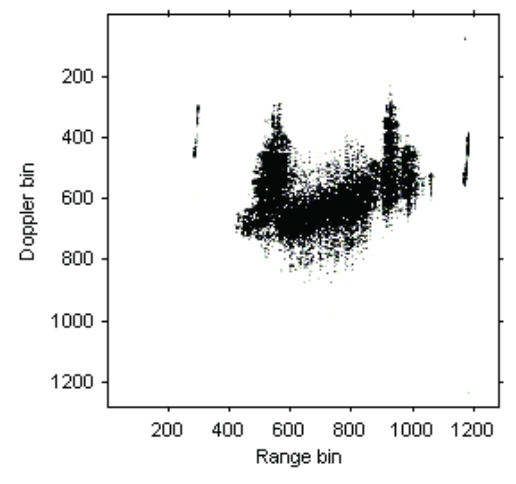
Figure 12. ISAR image based on RD algorithm.